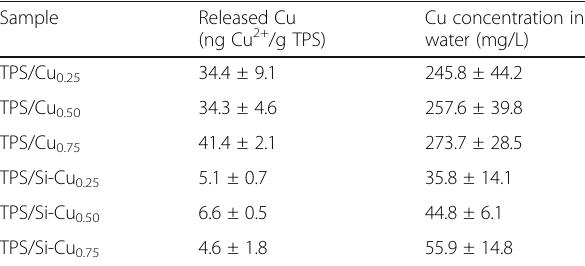
Table 2 Released copper from TPS composite films containing Cu and Si-Cu particles to water and copper concentration in the simulant aqueous medium Sample Released Cu Cu concentration in (ng Cu 2+ /g TPS) water (mg/L) TPS/Cu